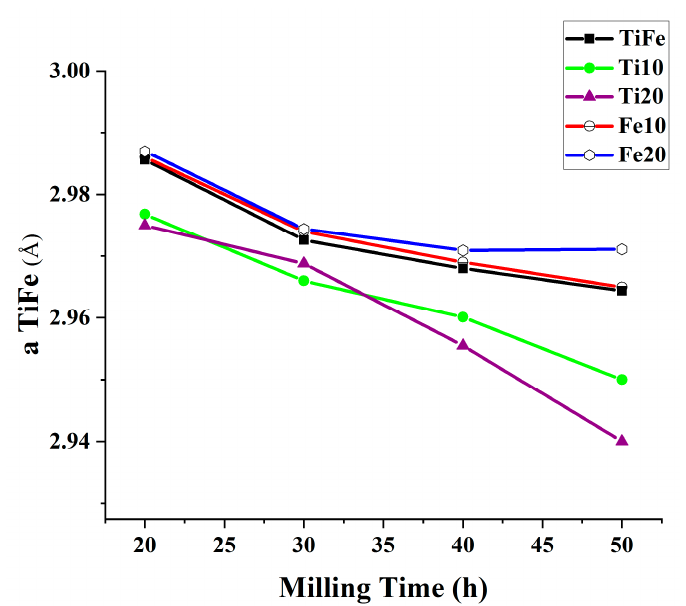
Figure 6. Lattice constant of TiFe-based crystal structure after different milling times for TiFe, Ti10, Ti20, Fe10, and Fe20 milled products.